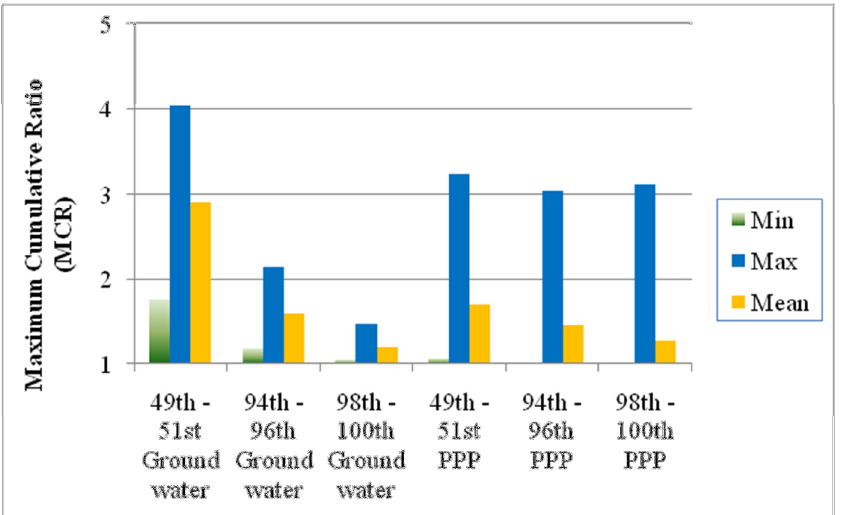
Figure 7. Comparison of the MCR values in three groups of the mixtures in the surface water samples analyzed for PPPs [1] and the results from this study (ground water